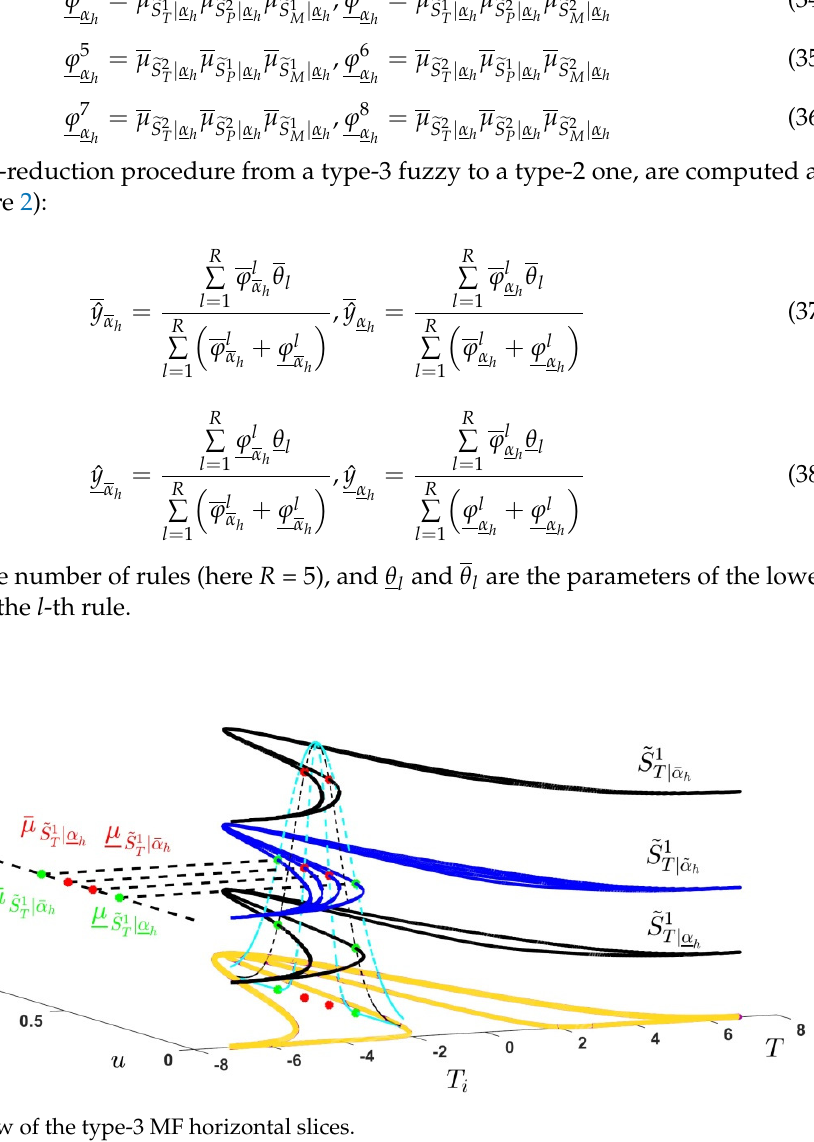
Figure 2. A view of the type-3 MF horizontal slices.